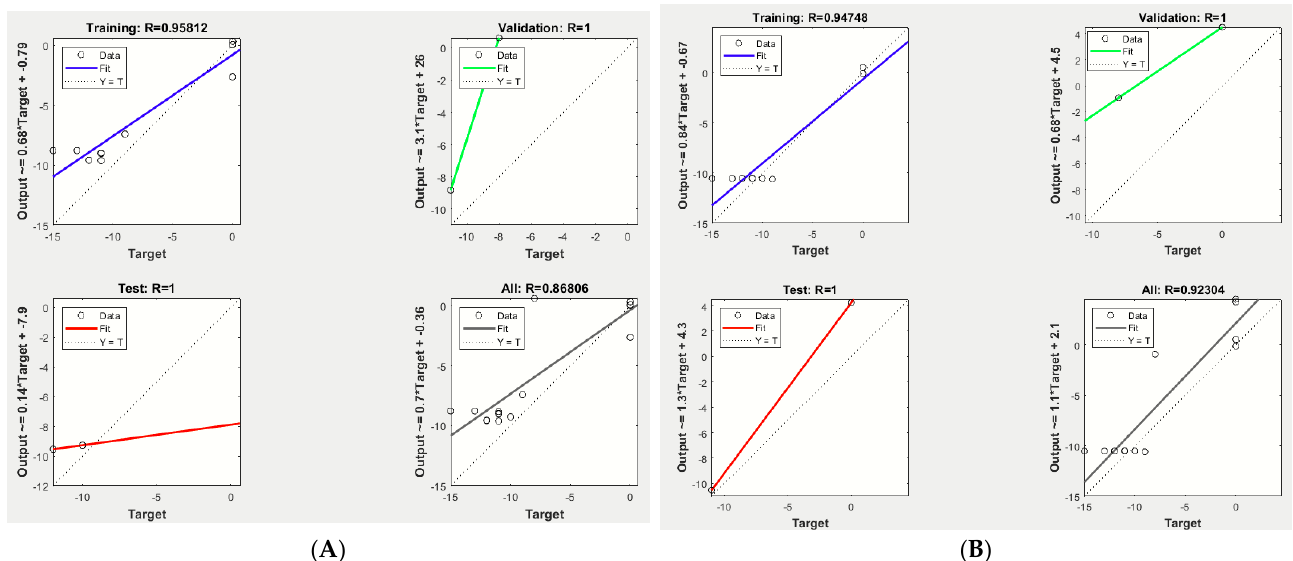
Figure 2. Coefficient (R 2 ) of training, testing, and validation data for antimicrobial production as determined by ANN analysis. ( A ) E. carotovora Erw 5 . ( B ) E. carotovora EMCC 1687.